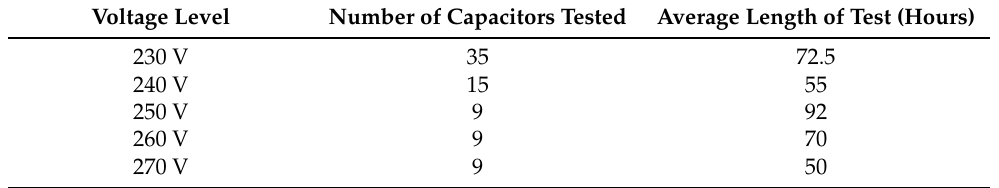
Table 2. Testing